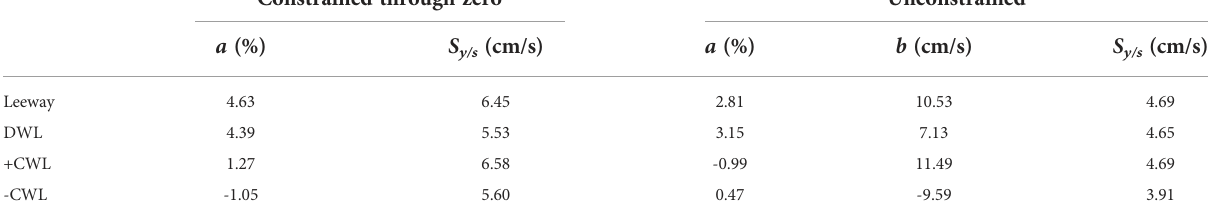
TABLE 5 The regression coef fi cients and standard errors. Constrained through